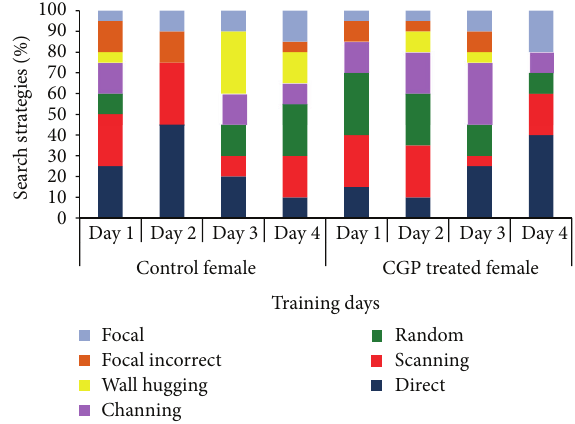
Figure 7: Swimming strategies of control and CGP 35348 treated femalealbinomouseduringacquisitionphaseofMorrisWaterMaze test.